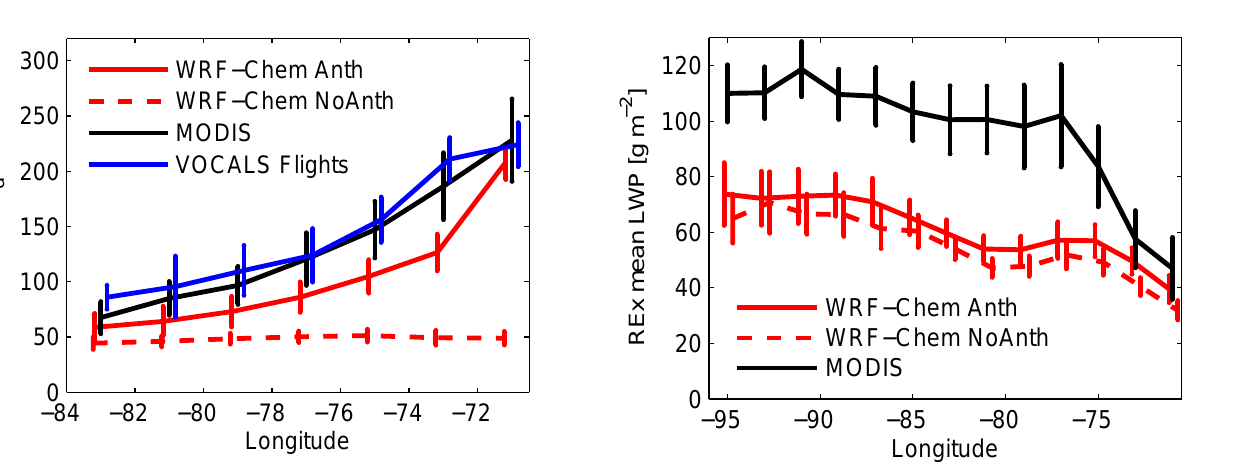
Fig. 5. VOCALS-REx mean LWP 19–21 ◦ S from MODIS (black) and WRF-Chem simulation at 15:00UTC (red) for Anth (solid) and NoAnth (dashed) simulations in 2 degree longitude bins. Error bars show the 95% confidence interval of the standard error of the